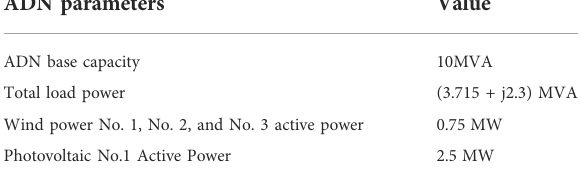
TABLE 2 Main parameters of